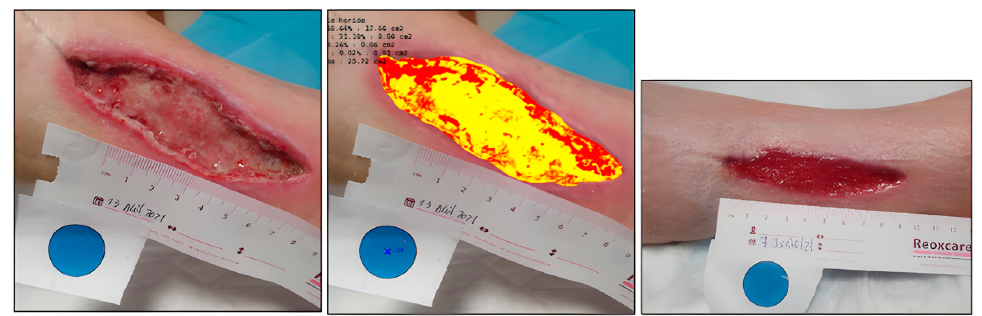
Figure 11. Healing evolution case 6: Baseline assessment ( left ), Baseline HELCOS analysis ( centre ), Week 13 assessment ( right